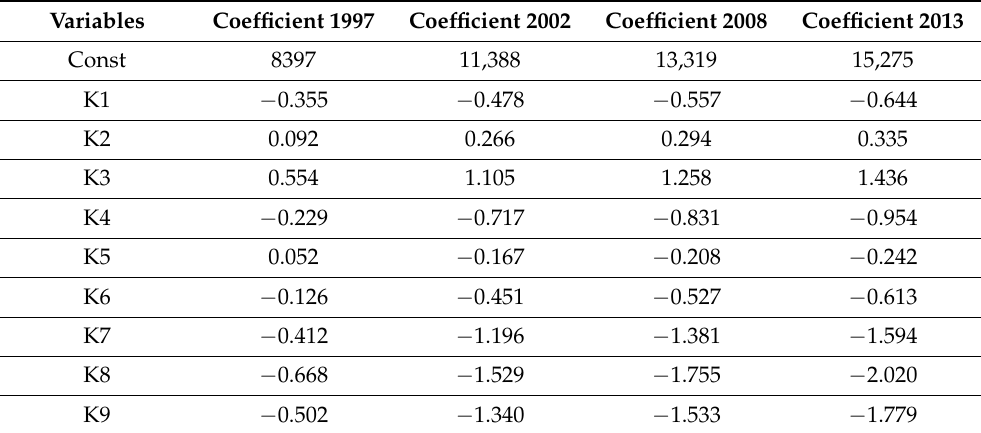
Table 4. Shadow prices for climate